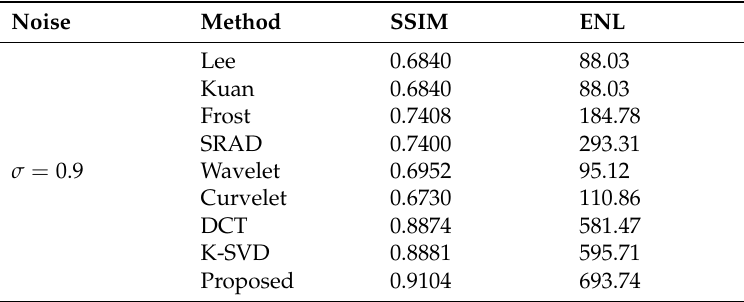
Table 3. The objective evaluation values of denoising